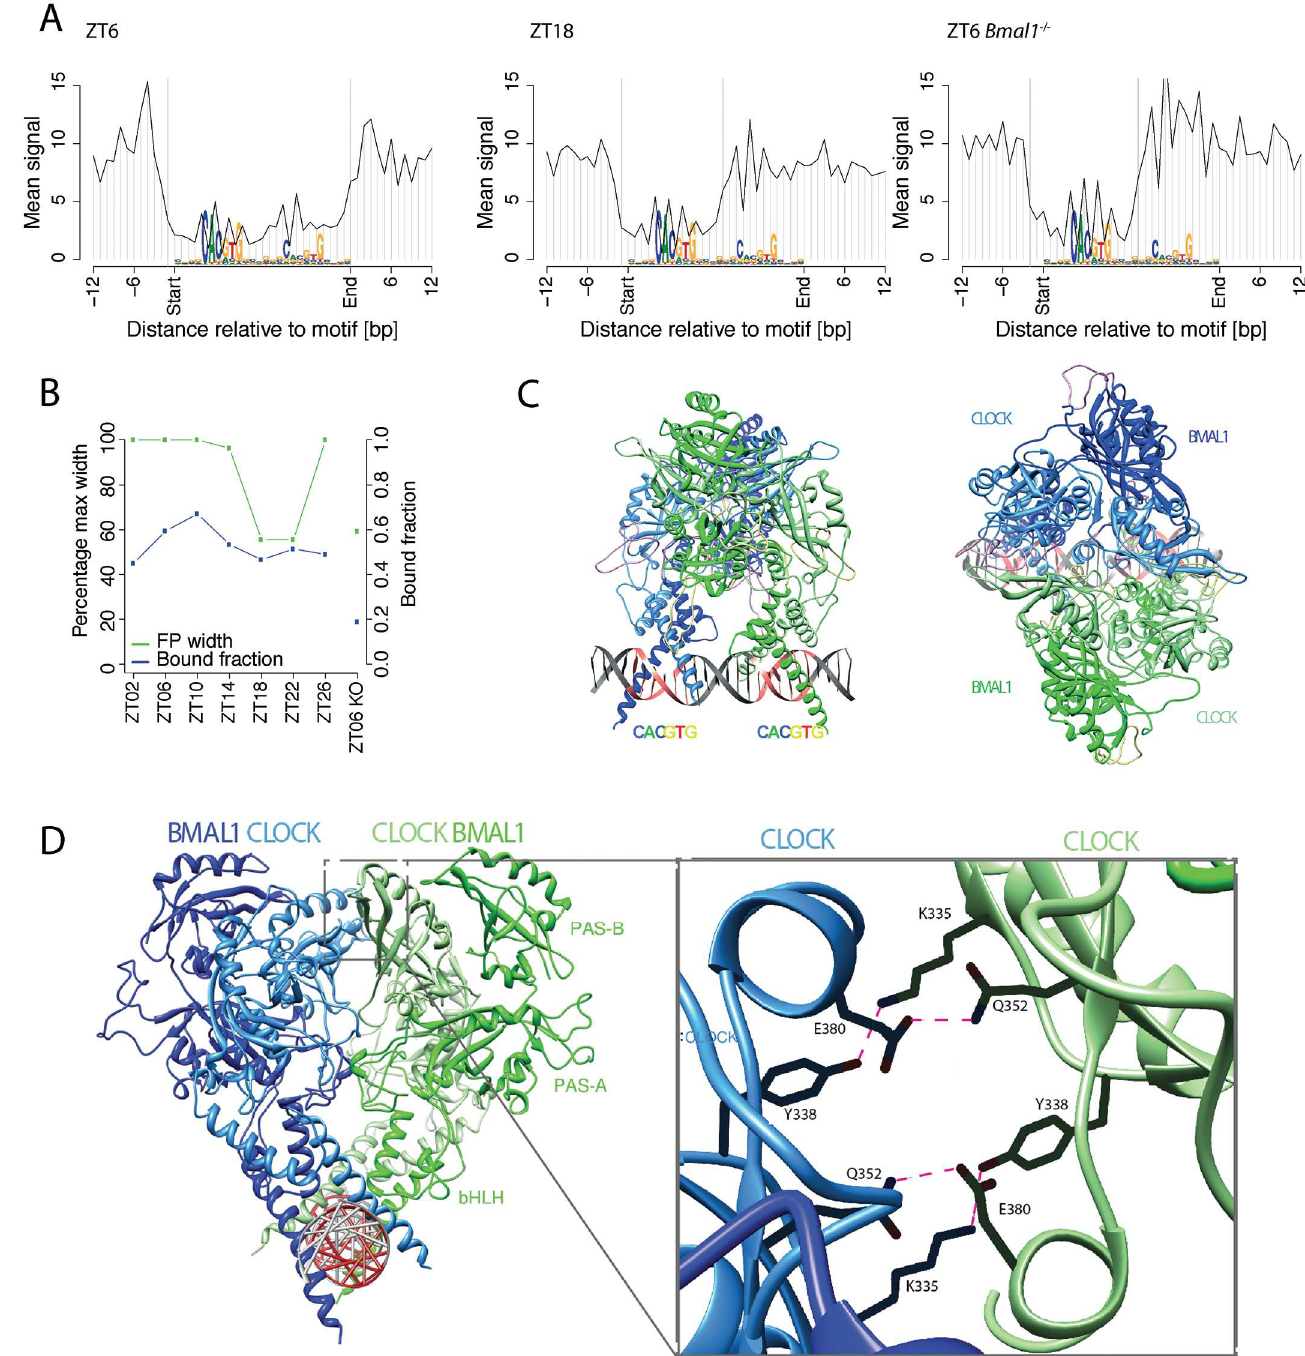
Fig 6. BMAL1 footprints indicate temporally changing protein–DNA complexes, consistent with binding of a heterotetramer to DNA. A. Genomic profiles of DNase I cuts arounddoubleE-boxes with a spacer of 6 bp (E1-E2 sp6). We selected n = 249 E1-E2 sp6 motifs overlapping a BMAL1 chromatin immunoprecipitationfollowedby DNA sequencing (ChIP-seq) peak and show the averageof profiles for loci classifiedas bound by the mixture model (posteriorprobability > 0.5). At ZT6, we observedthat nucleotides aroundboth E-boxes are protected. In contrast, at ZT18, the width of the protected regionis reducedby approximately half, with the second E-box no longerprotected from digestion.The signals are anchored to the motif position.Orientationof sites and signals is accordingto the best match to the E1-E2 sp6 motif. In Bmal1 -/- , only one E-box appearsoccupied.B. Width (left-side y -axis, green) of the protectedregionin WT and in Bmal1 -/- mice for E1-E2 sp6 motifs occupiedby BMAL1. Fraction of predicted occupiedsites is shown in blue (right-side y -axis). C. Two views of the 3-D computational model of the CLOCK:BMAL1 heterotetramer showingtwo